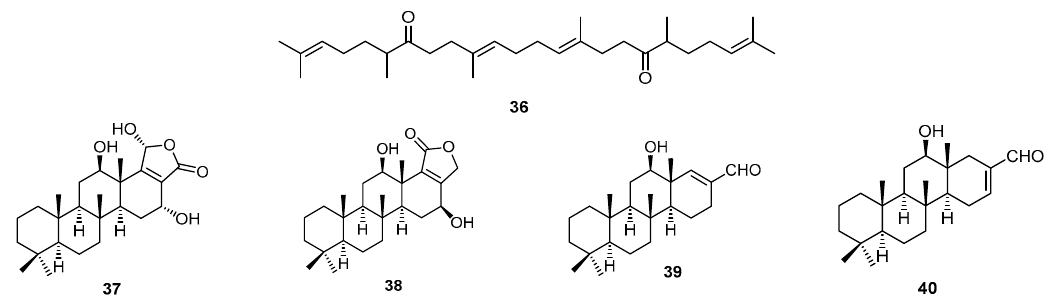
Figure 10. Chemical structures of the diketotriterpenoid 36 , hyrtiolide ( 37 ), 16-hydroxyscalarolide ( 38 ), 12-deacetyl- ∆ 17 -hyrtial ( 39 ) and 12-deacetylhyrtial ( 40 ). Hyrtiosulawesine ( 41 ), a β -carboline alkaloid, together with 5-hydroxyindole-3-carbaldehyde ( 1 ), hyrtiosin B ( 3 ), and 5-hydroxy-3-(2-hydroxyethyl)indole ( 34 ) were isolated from the Indonesian